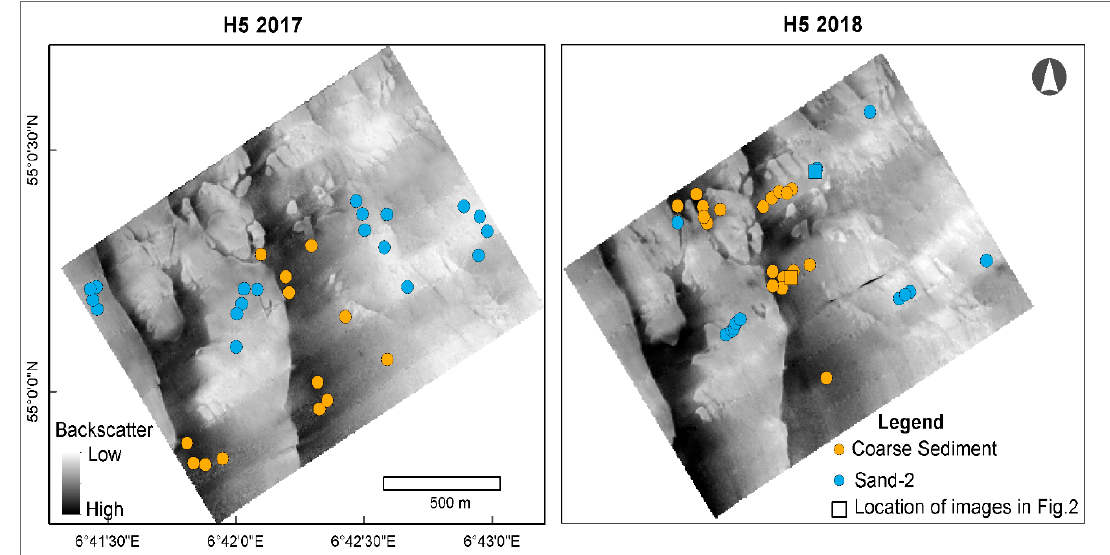
Figure 3. Side-scan mosaics collected in 2017 and 2018 with the location of sampling stations in H3. The locations of the images presented in Figure 2 are represented by squares.